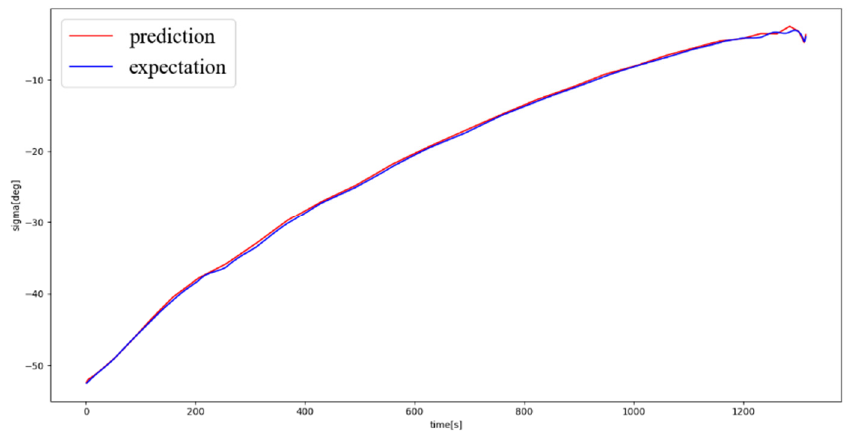
Figure 7. Comparison of the predicted and expected values of the inclination angle.